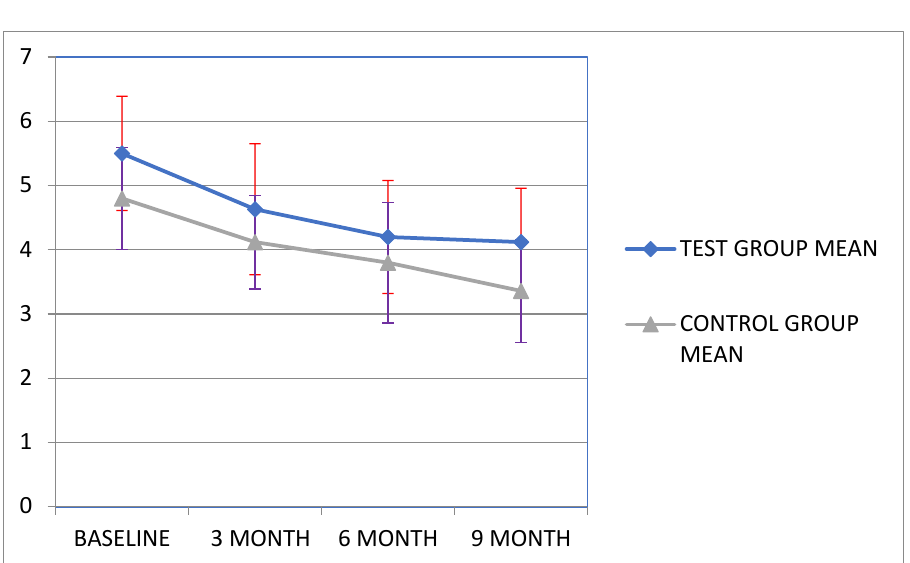
Scheme 1. Intergroup comparison of mean pocket depth (in millimeters).